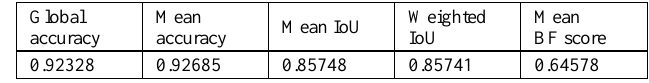
P ERFORMANCE OF THE SSN T RAINED FOR O NE E POCH BY F IG . 4 FOR THE U PPER P ART R ESULTED IN B ADLY S EGMENTING THE E MPTY I MAGE